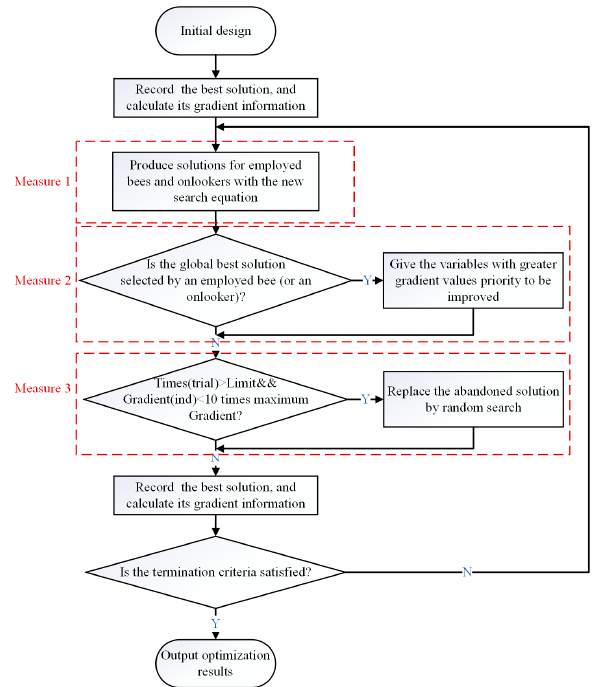
Figure 2. Flow chart of the improved algorithm.